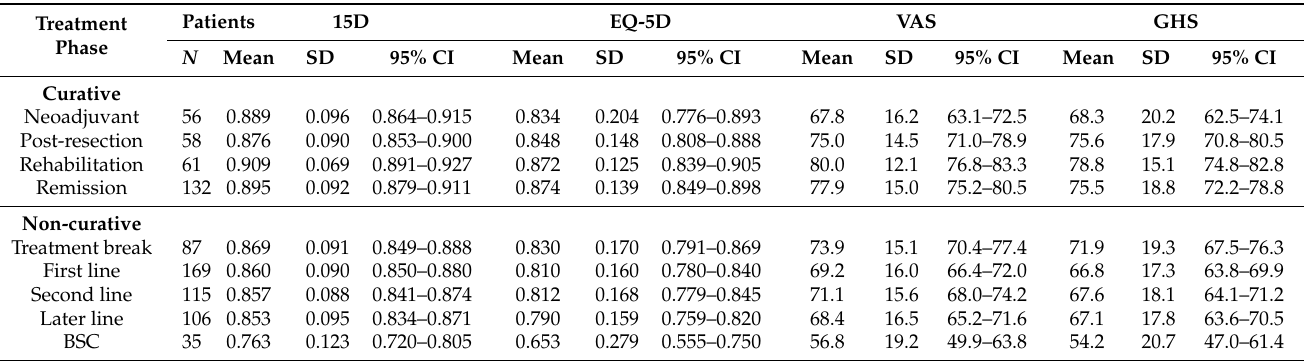
Table 2. Mean health-related quality of life scores during treatment